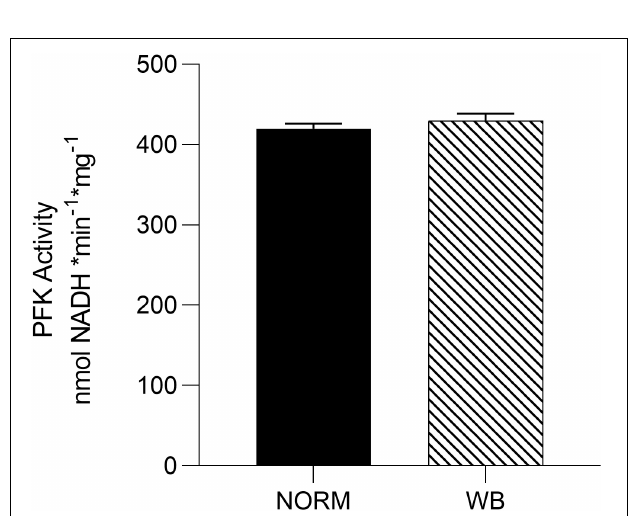
FIGURE 5 | Average phosphofructokinase (PFK) activity [nmol nicotinamide adenine dinucleotide (NADH) * min - 1 * g − 1 ] of unaffected (NORM) and wooden breast (WB) pectoralis major muscles ( n = 6/group). Data represent means ±